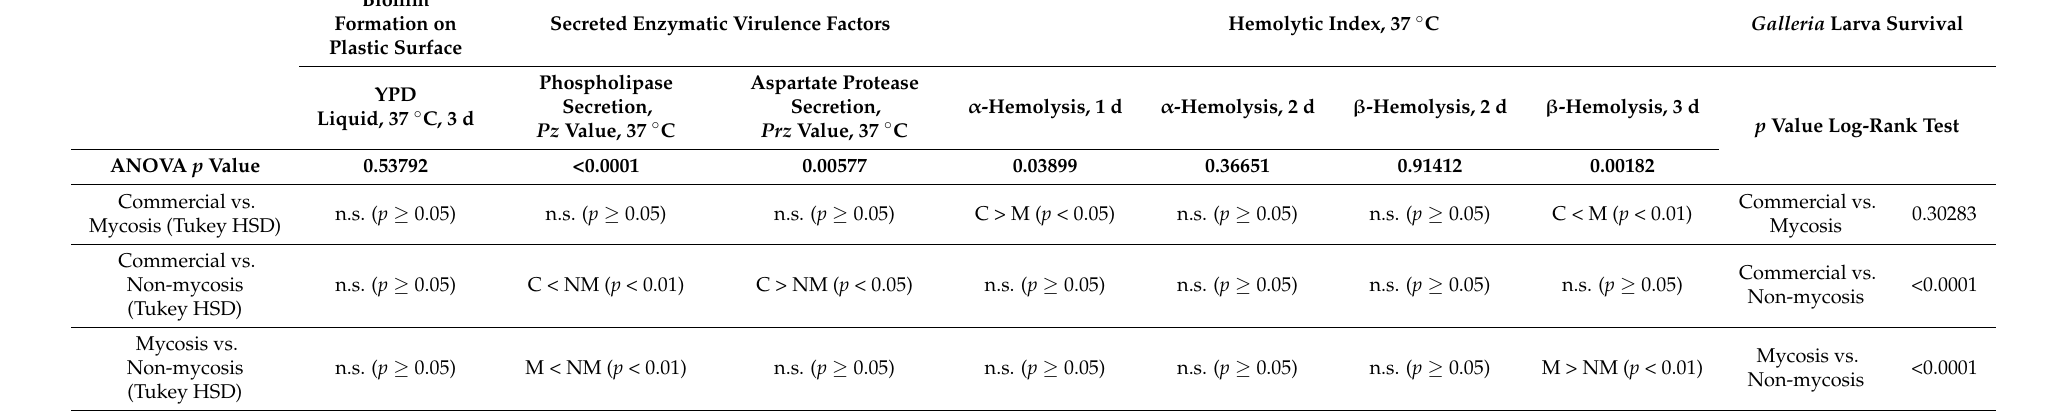
Table 2. Statistical comparison of isolate groups for measurable phenotypes and for Galleria experimental infections. Statistical results for single-cell phenotyping are shown in Supplementary File